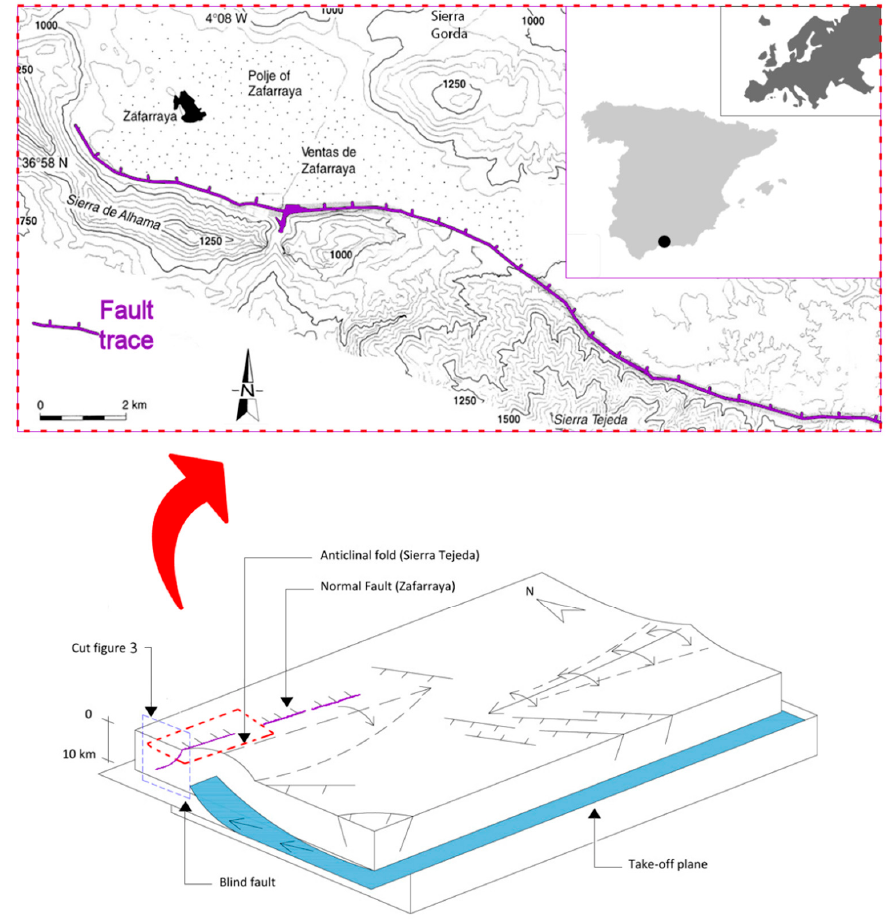
Figure 1. ( Above ) location of the study area and trace of the Zafarraya Fault, source of the 1884 Andalusia earthquake (Adapted from [16]). ( Below ) tectonic schematic of the simultaneous develop- ment of folds with possible blind thrust faults and two normal fault systems in a detachment roof block. Type I faults, such as the Zafarraya Fault, would be produced by external arc extension and collapse of the antiforms that constitute the main E–SW reliefs. Type II faults would respond to the regional stress field with a NE–SW extension direction (Adapted from [17]).